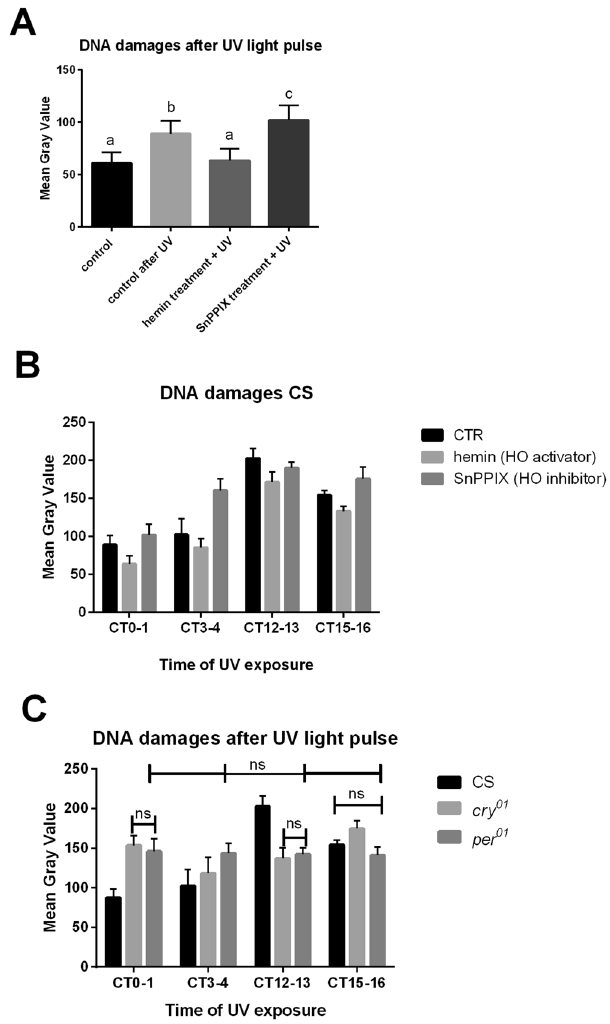
Figure 5. Oxidative DNA damages after UV and intense white light exposure. DNA damages were evaluated as the intensity of labeling with anti-8-hydroxyguanosine, followed by DAB/HRP enzymatic reaction and measured as Mean Gray Value using ImageJ software. ( A ) Before light exposure wild-type flies were fed a HO inhibitor (SnPPIX), HO activator (hemin) or glucose only (control 1). Flies were exposed to 1 h UV light pulse starting at CT0. One group of flies without UV treatment was used as an additional control (control 2). Statistically significant differences are shown as different letters. ( B ) Canton S (CS) flies were fed with hemin, SnPPIX or glucose (CTR) and exposed to UV light at different time points. There are statistically significant differences between CTR and experimental flies at every time point as well as between different time points in all groups of flies. ( C ) Canton S (CS), cry 01 and per 01 flies were exposed for UV light at different time points. There are statistically significant differences between CS at every time point: CT0-1 vs. CT3-4 with p < 0.01, other time points with p < 0.0001. There are statistically significant differences in cry 01 at every time point: CT0-1 vs. CT12-13 with p < 0.01, other time points with p < 0.0001. There are no statistically significant differences in case of per 01 at different time points (labeled as ns). At specific time points there are differences between: CS vs. cry 01 at CT0-1 (p < 0.0001), CS vs. per 01 at CT0-1 (p < 0.0001), CS vs. cry 01 at CT3-4 (p < 0.05), CS vs. per 01 at CT3-4 (p < 0.0001), cry 01 vs. per 01 at CT3-4 (p < 0.0001), CS vs. cry 01 at CT12-13 (p < 0.0001), CS vs. per 01 (p < 0.0001) at CT12-13, CS vs. cry 01 at CT15-16 (p < 0.001), cry 01 vs. per 01 at CT15-16 (p <